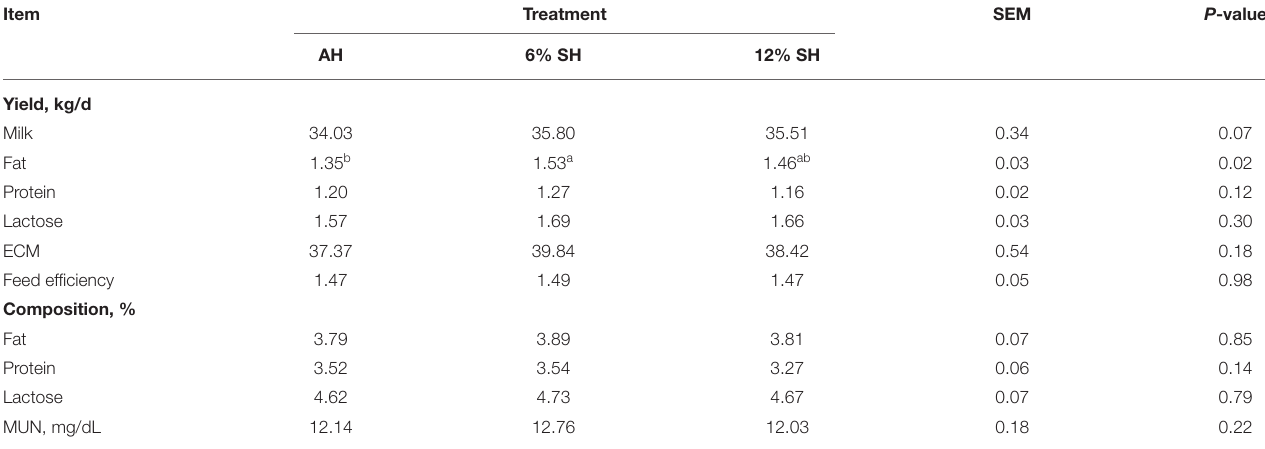
TABLE 4 | Effect of partial substitution of AH by SH on milk yield and milk